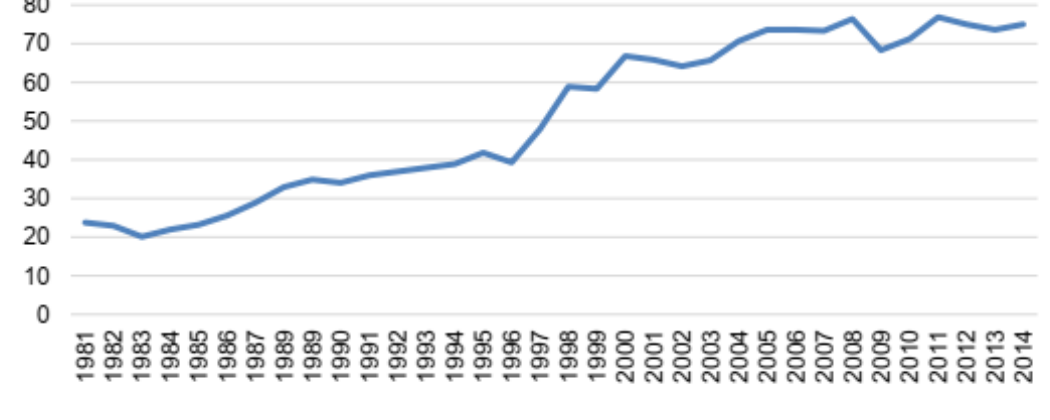
Figure 4: Exports (% of GDP) of Thailand (1981-2014)